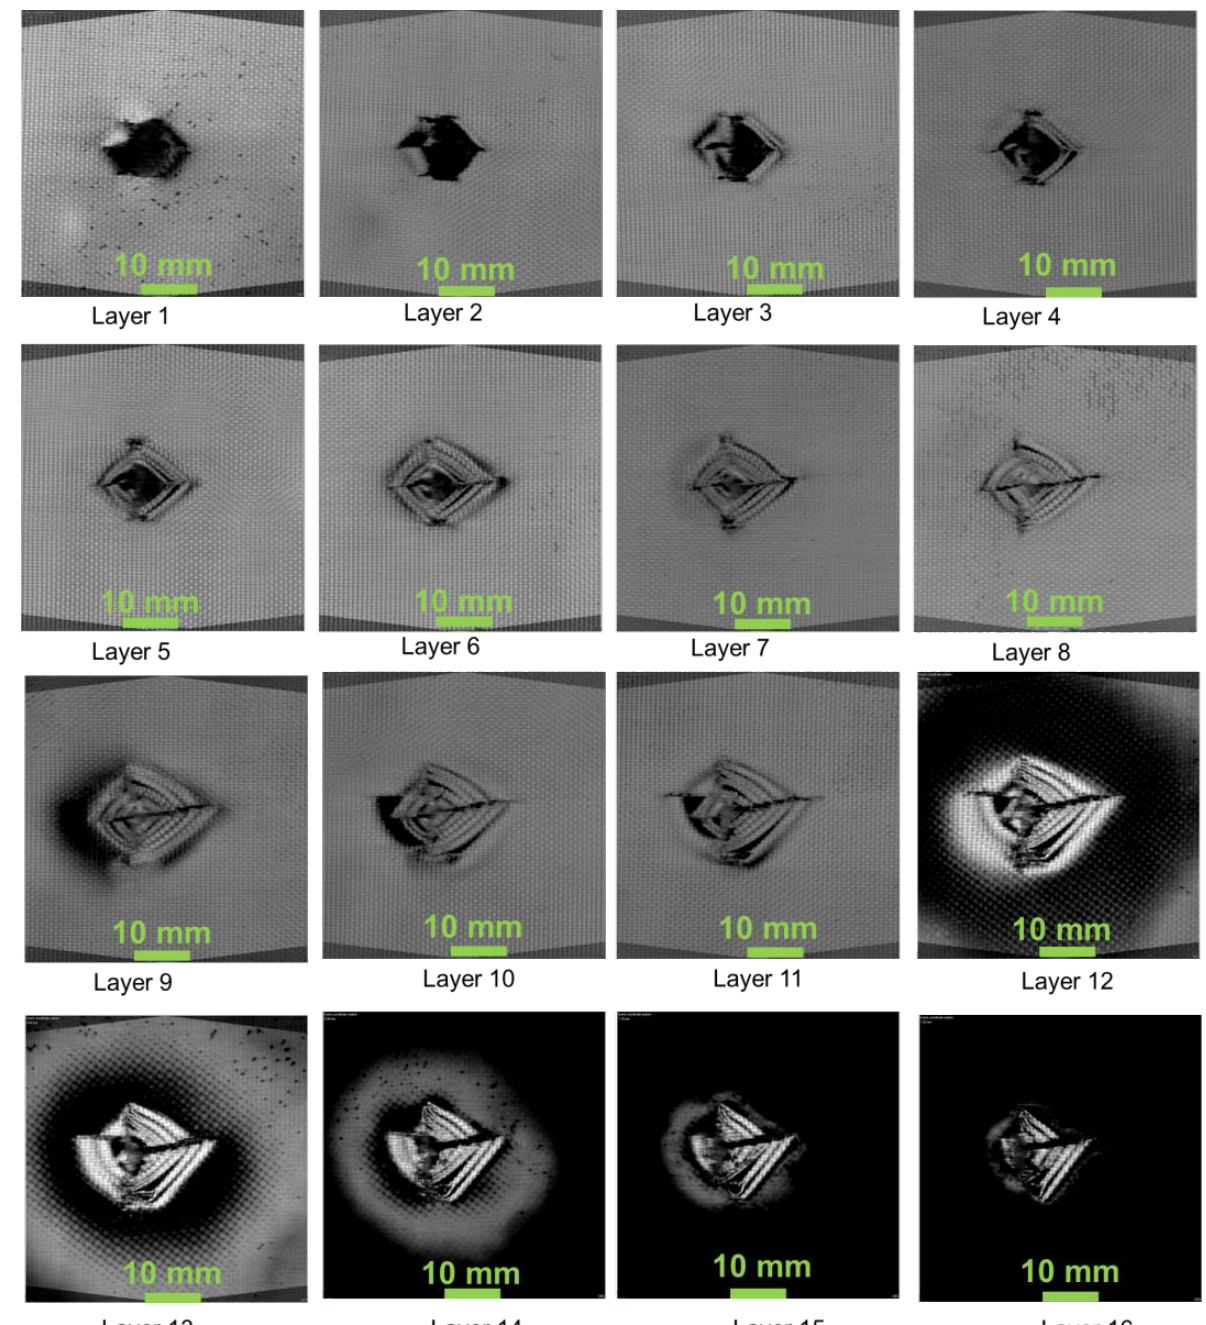
Figure 8. 45 1k /0 14E /45 1k —composite laminate failure on each layer. Figure 10 shows the side view of the X-ray computerised tomographic scan images of the composites. The composite with 45 ◦ fibre orientation had reduced rear plate bulge (cone radius) compared to the composite laminates with 0 ◦ and 45 ◦ fibre orientation. This explains the high energy absorption of the composites laminate with 45 ◦ fibre orientation. The 0 ◦ composite has ‘through’ hole due to impact of the projectile at a concentrated load. Murugan et al. [29] reported that the higher the cone radius, the lower is the energy absorption. As explained, the 60 ◦ orientation had a high cone radius and lower energy absorption compared to the other two fibre